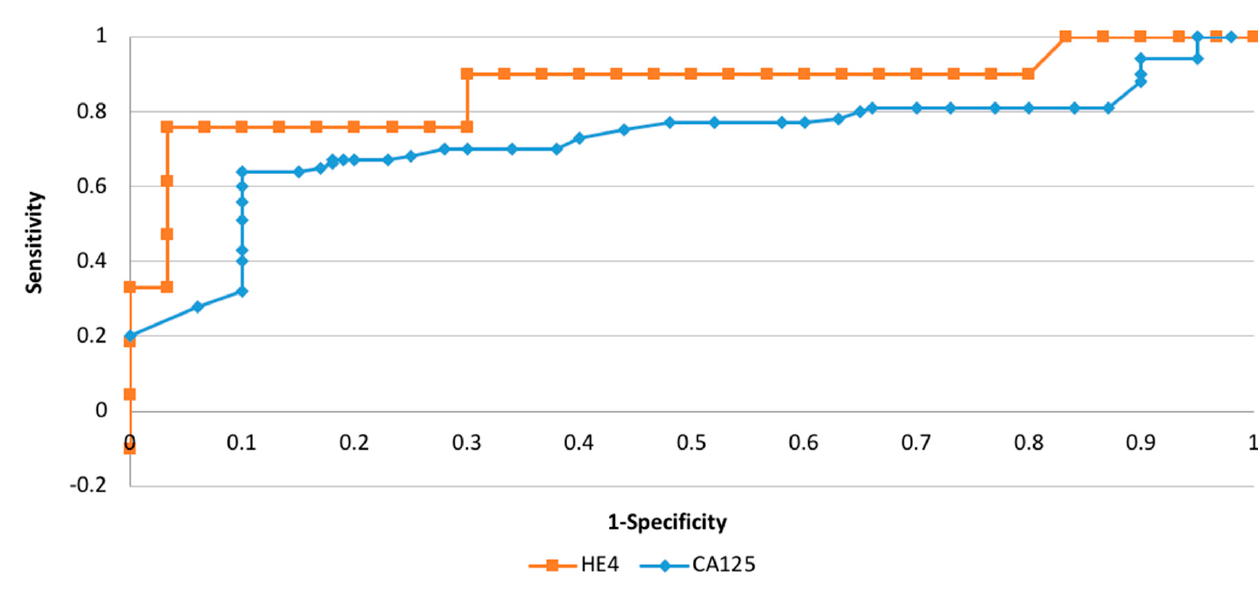
Figure 2. The ROC curves for HE4 markers depending on staging (AUC = 0.88).